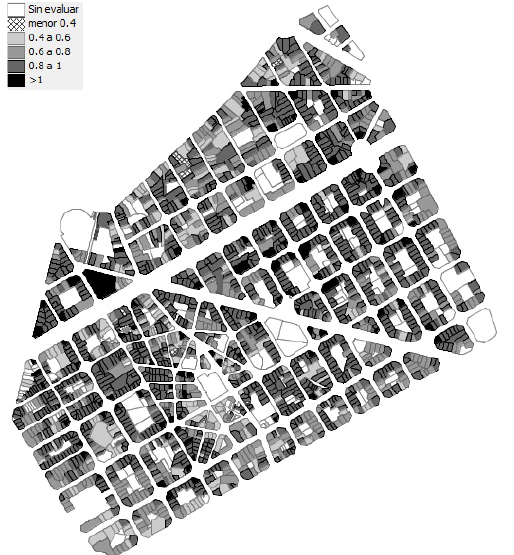
Figure 17. Map of Vulnerability Indices in L’Eixample district Valencia (Guardiola-Víllora A, Basset-Salom L,